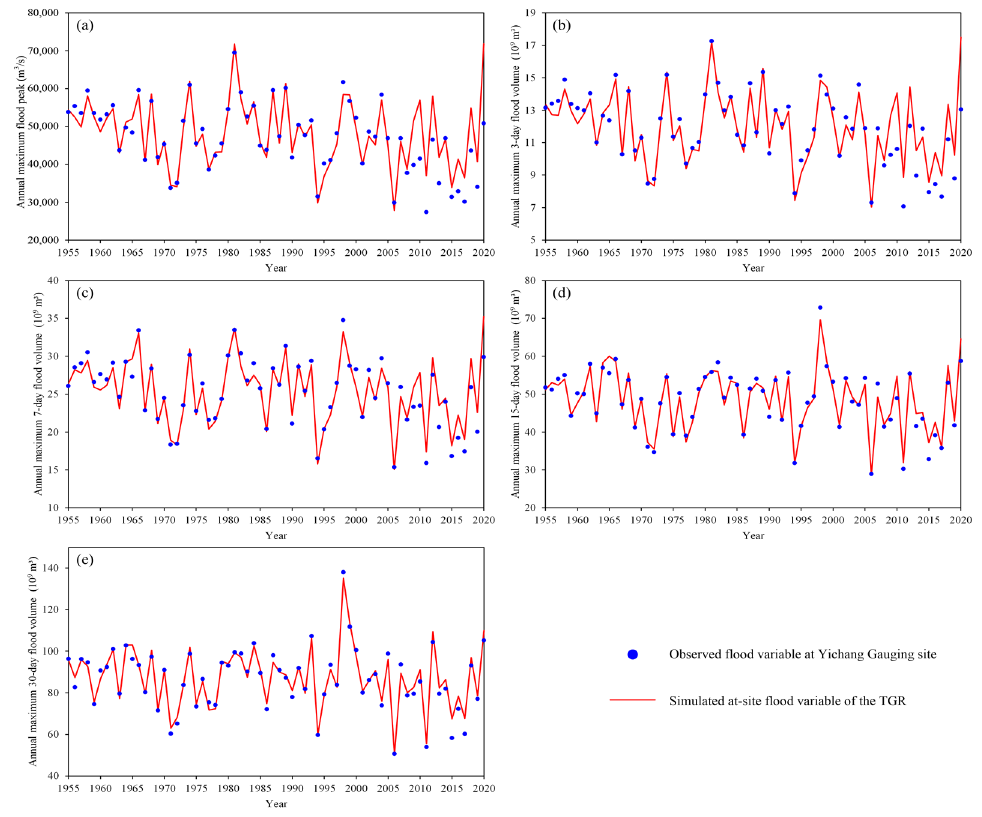
Figure 3. Observed flood variables at Yichang gauging site and the simulated at-site flood variables of the TGR. Panels ( a – e ) display the results for the flood variables Q 1 , V 3 , V 7 , V 15 and V 30 , respectively.